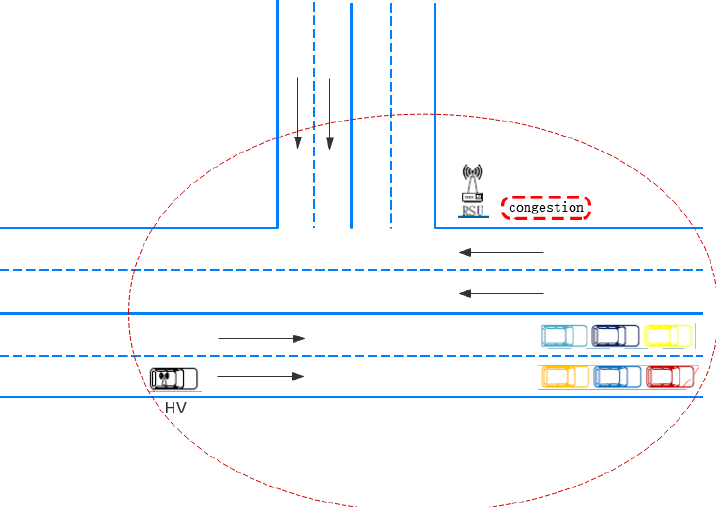
Figure 5. Typical scene of congestion ahead of the